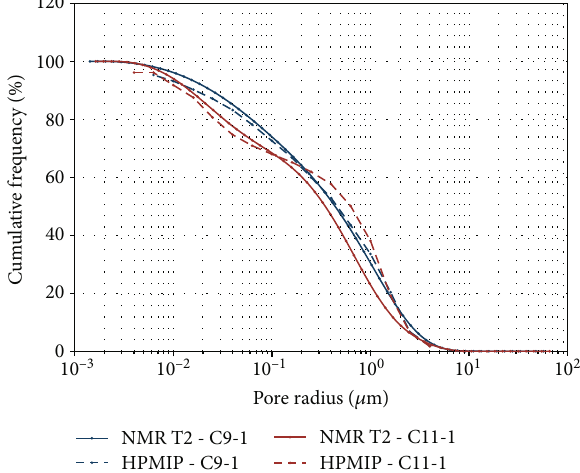
Figure 4: The fi tting of cumulative frequency